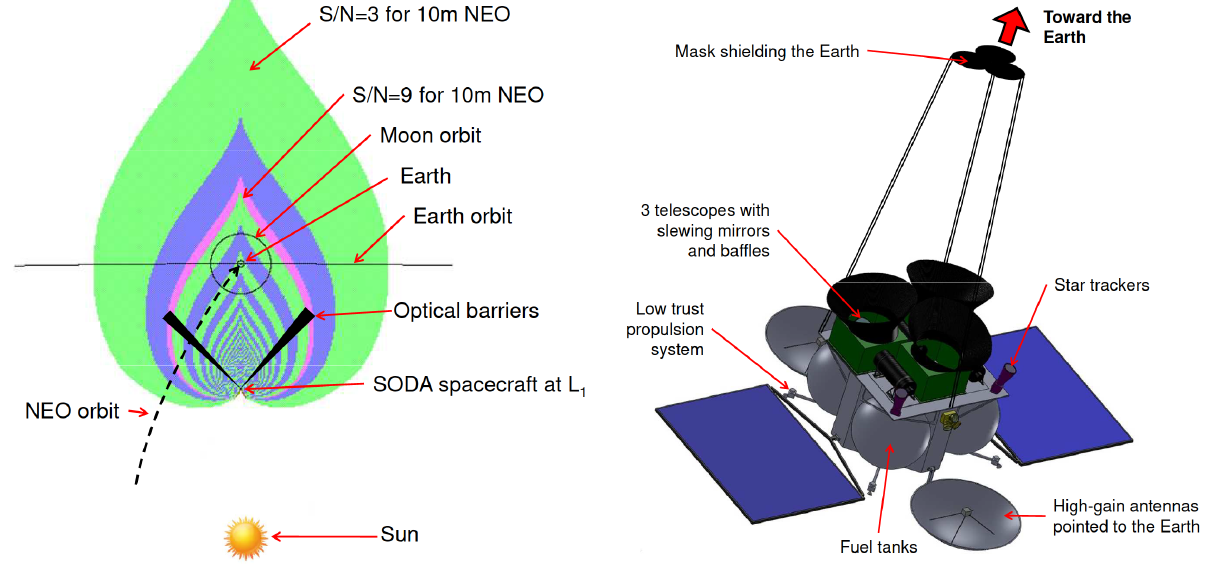
Figure 4. Visibility zone of 10 m NEO from L1 for SODA’s